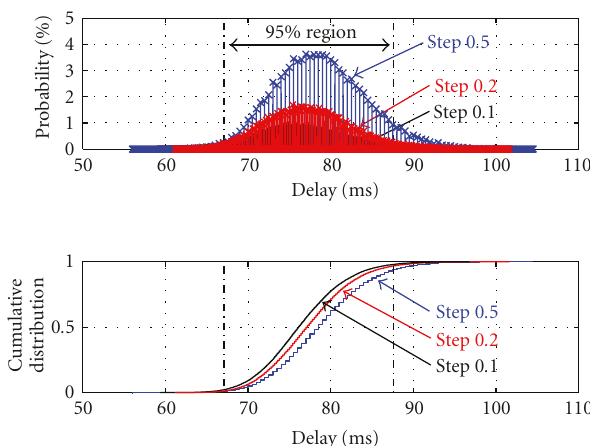
Figure 12: Message delay and its Cumulative Distribution at last node, for 20 nodes chain.